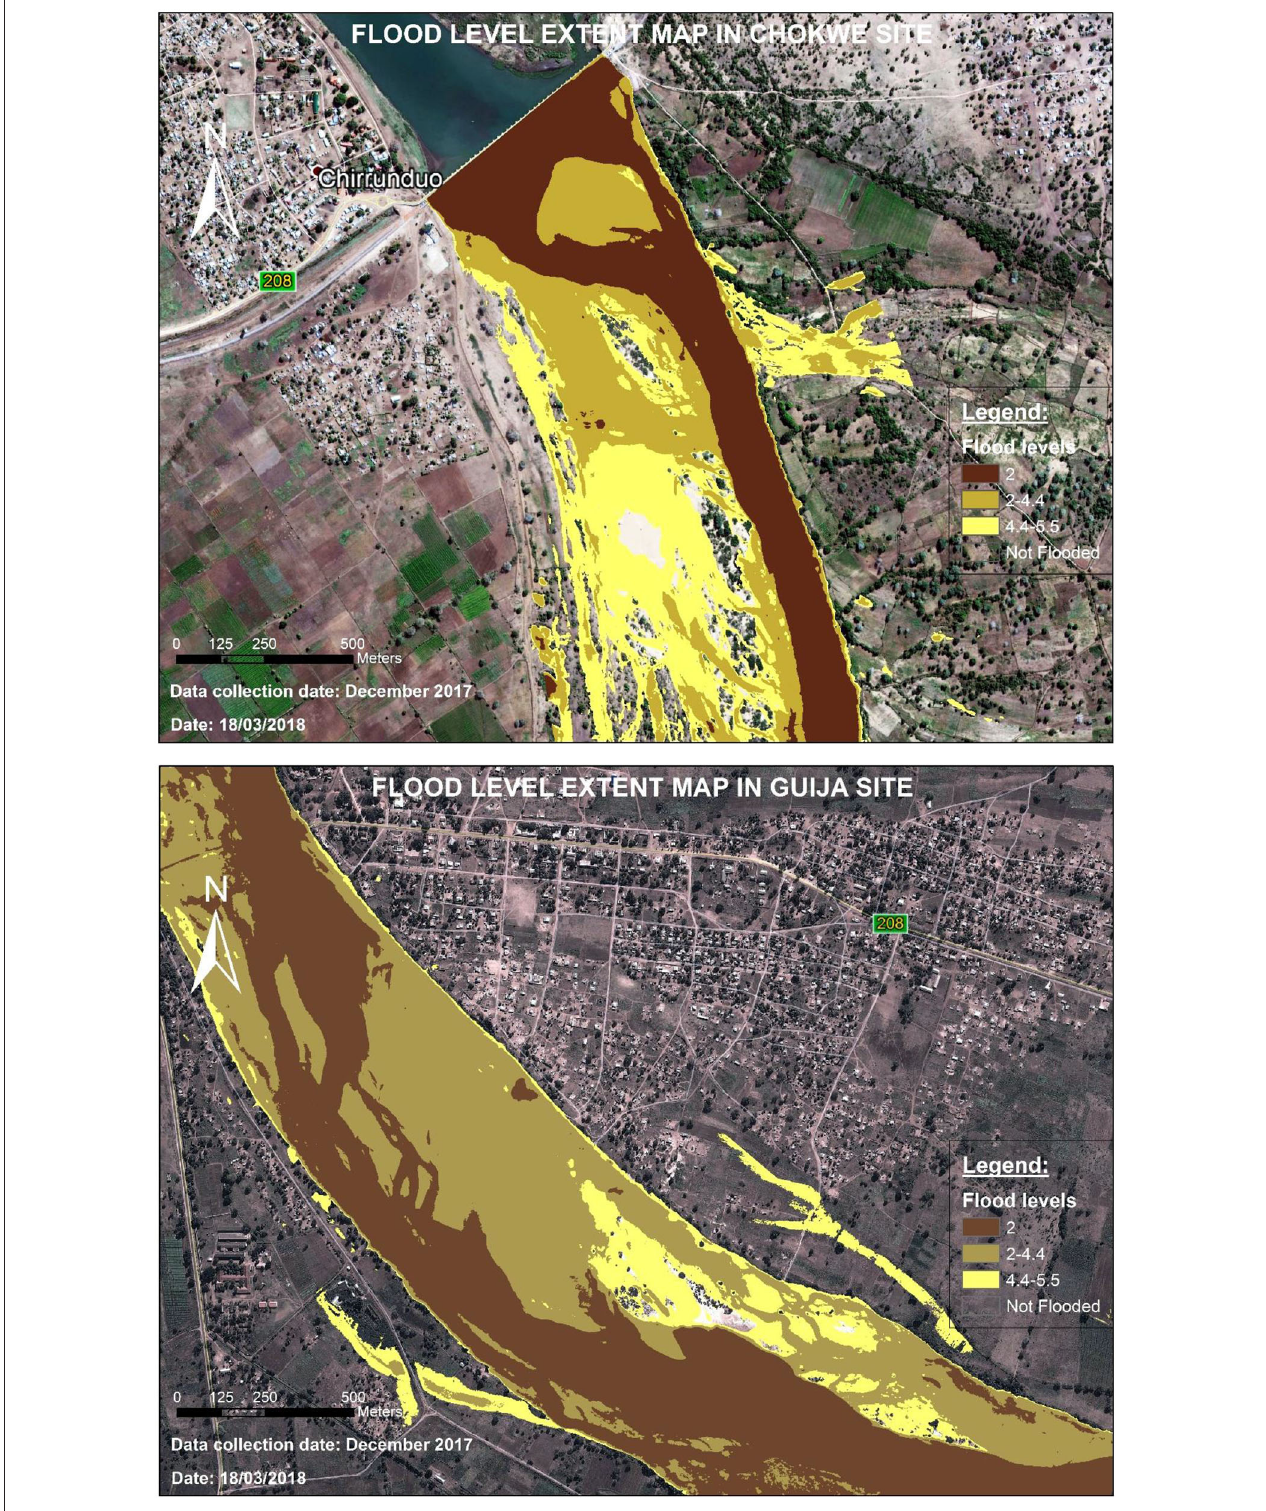
FIGURE 6 | River stage thresholds and the respective area of the river valley that is flooded at the two study sites; the base map is derived from satellite imagery Google Earth pro 2017, Map data: Google, DigitalGlobe 2017.